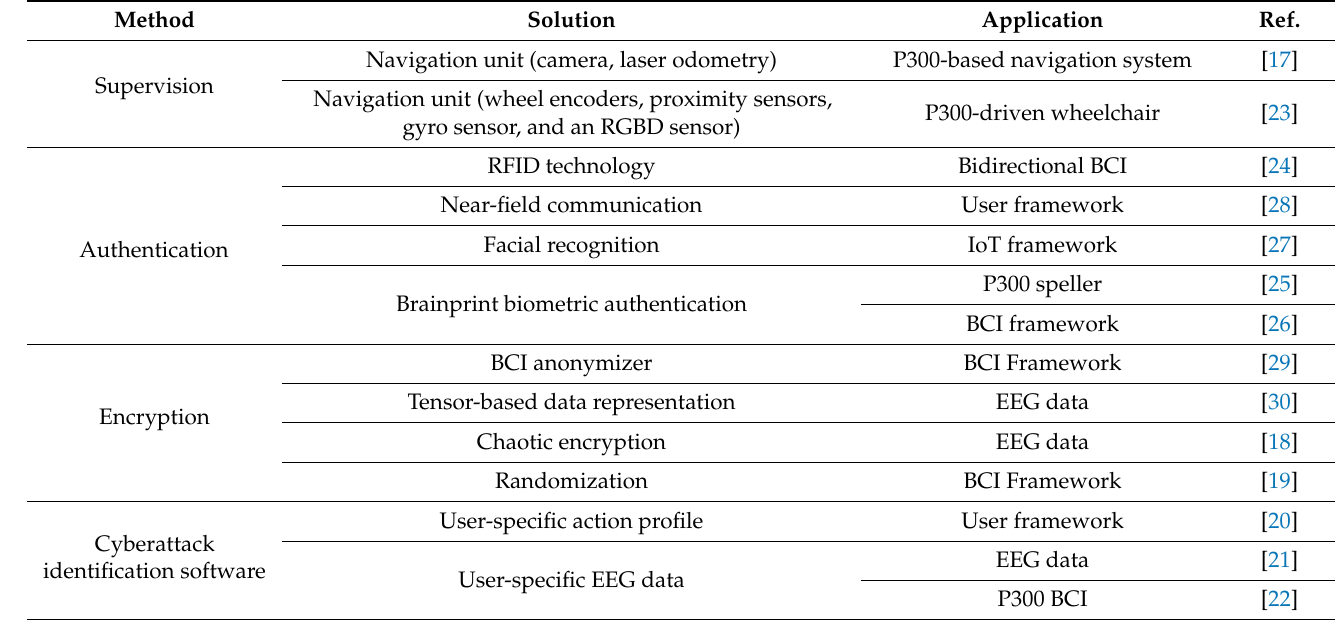
Table 1. State-of-the-art cybersecure